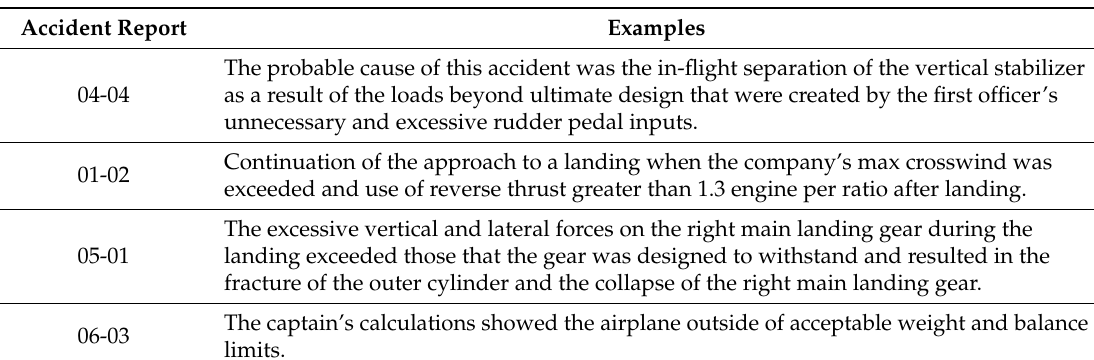
Table 9. Examples of Flying Outside the Envelope.